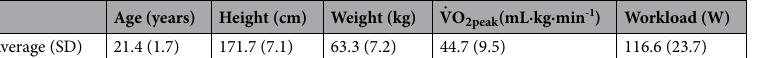
Table 2. Participants’ characteristics. Age, height, weight, peak oxygen intake ( workload for moderate-intensity exercise are presented as the mean and standard deviation for the 14